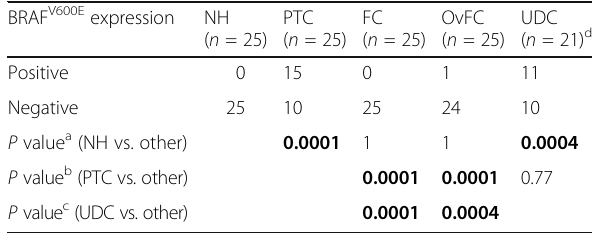
Table 4 BRAF V600E expression in thyroid nodular hyperplasias and follicular cell-derived